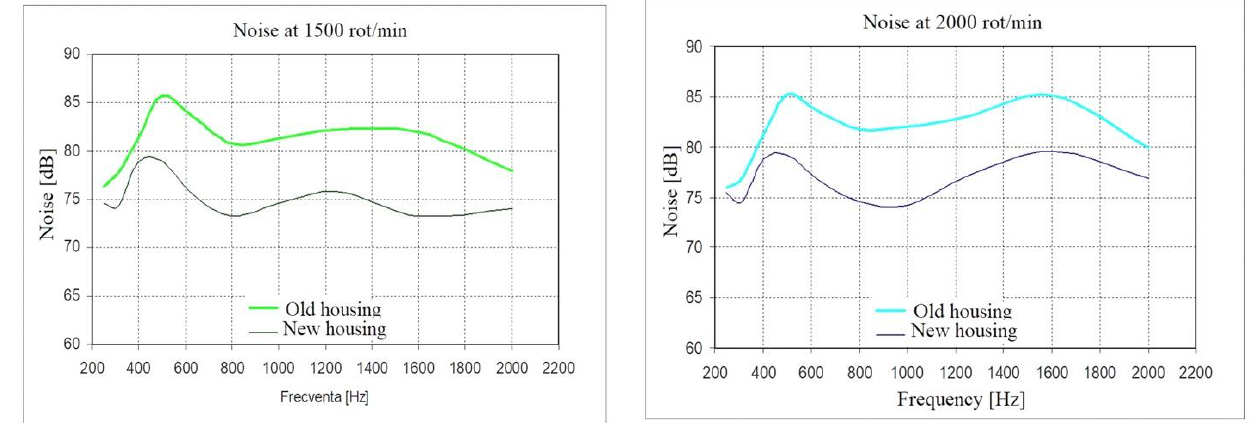
Figure 33. Lp sound pressure level diagrams for rear surface at 1500 and 2000 rpm.